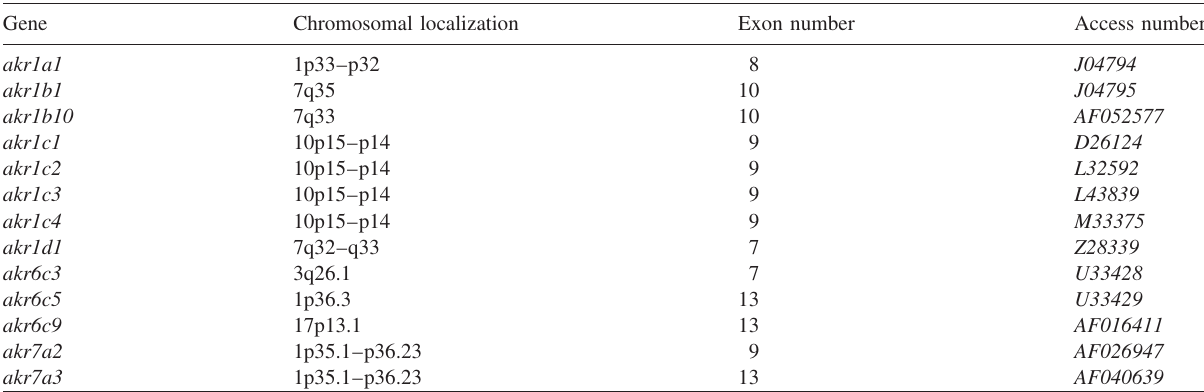
Table 2 Chromosome locations and structures of human AKR